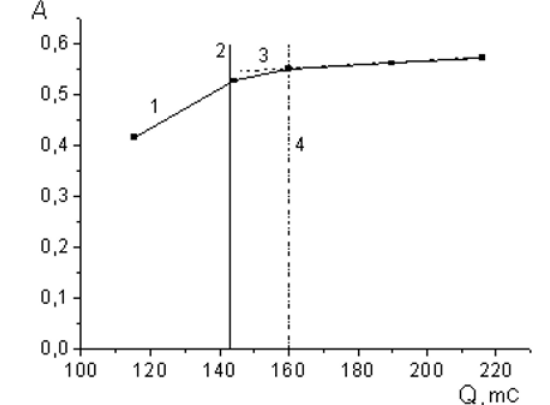
Figure 1. Absorbance vs. quantity of charge curve for iodine- iodide complexes with brilliant green in CCl . (1) 4 C = 1×10 -6 mol L -1 , C = 2×10 -5 mol L -1 ; (2) point, KI KBr conforming to the theoretical estimation of quantity of charge, which is necessary for cooxidation of iodide and bromide; (3) accumulation of residual current curve; (4) point, conforming to the experimental needed quantity of electricity for cooxidation of iodide and bromide.